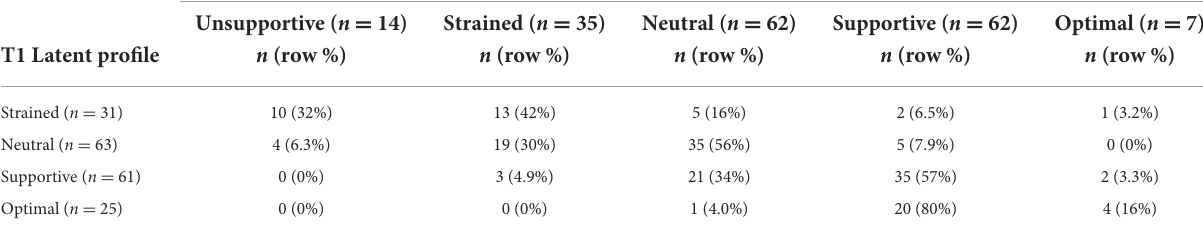
TABLE 11 Crosstabulation of latent profile transitions from T1 to T2 ( N =